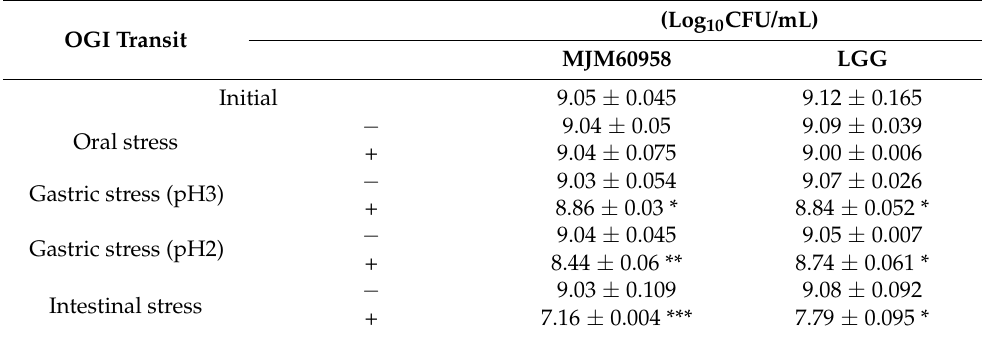
(Log 10 CFU/mL) MJM60958